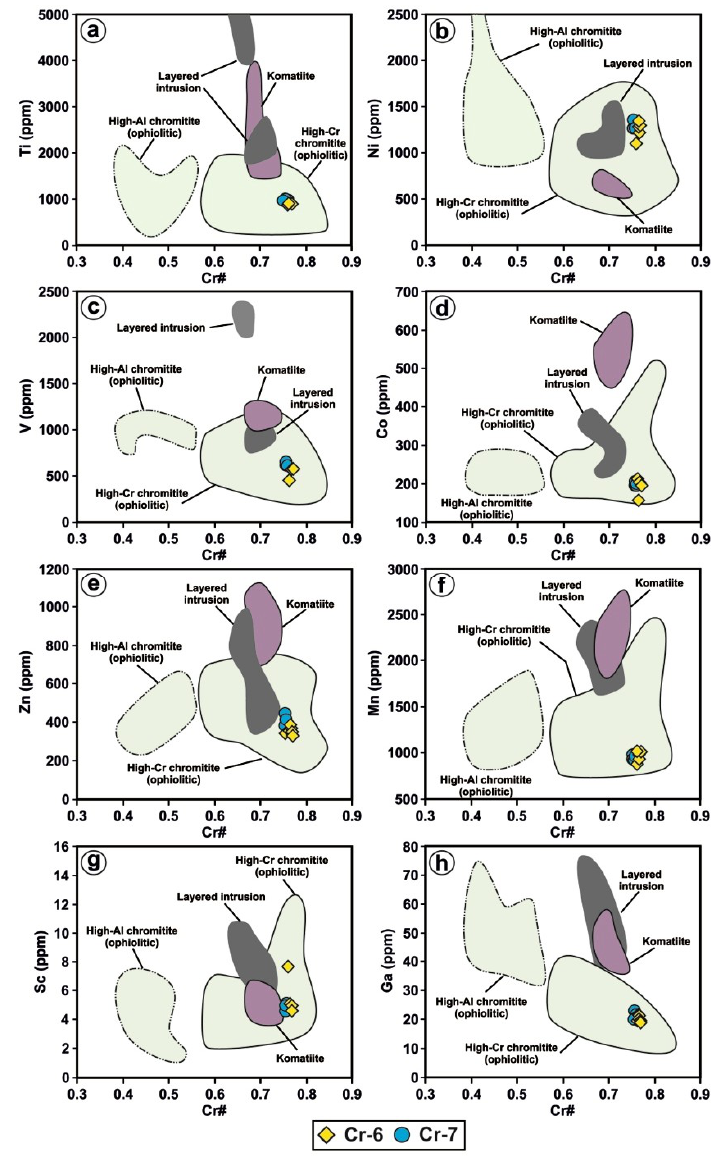
Figure 3. Compositional variation in terms of Cr# vs. ( a ) Ti, ( b ) Ni, ( c ) V, ( d ) Co, ( e ) Zn, ( f ) Mn, ( g ) Sc and ( h ) Ga in chromites from the Andaman ophiolite chromitites. Data sources for the compositional fields of other worldwide chromitites and accessory chromite from komatiites are from [12]. 4.2. Elememtal and Isotopic Composition of Platinum-Group Minerals in